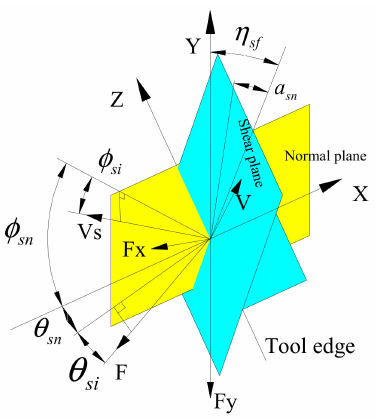
Figure 6. Geometric relationship of cutting force